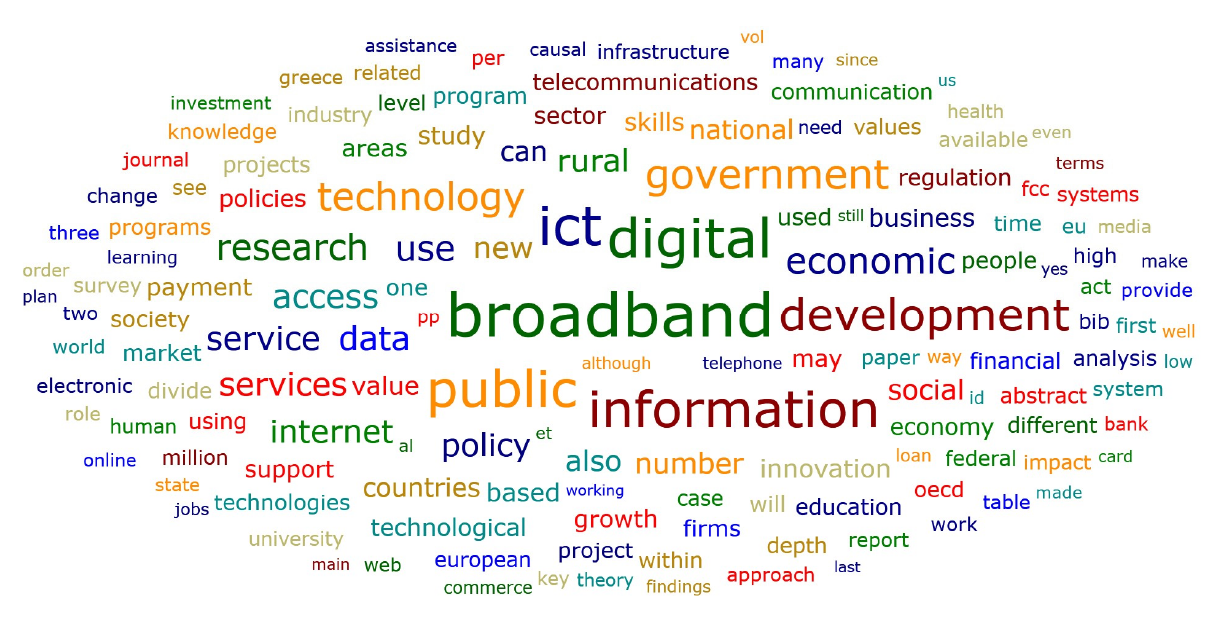
Figure A1. Word document search. Source: Author’s computation.